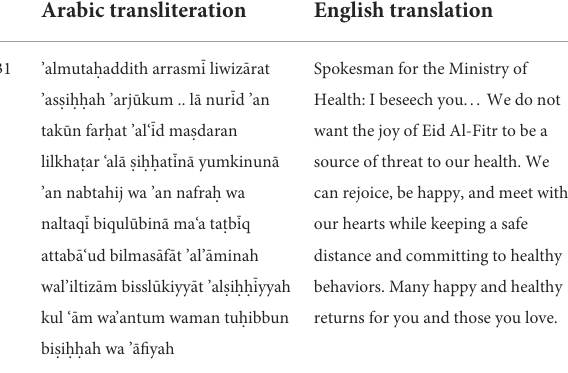
TABLE 13 Examples of the use of the liking–unity–commitment–authority pattern. Arabic transliteration English